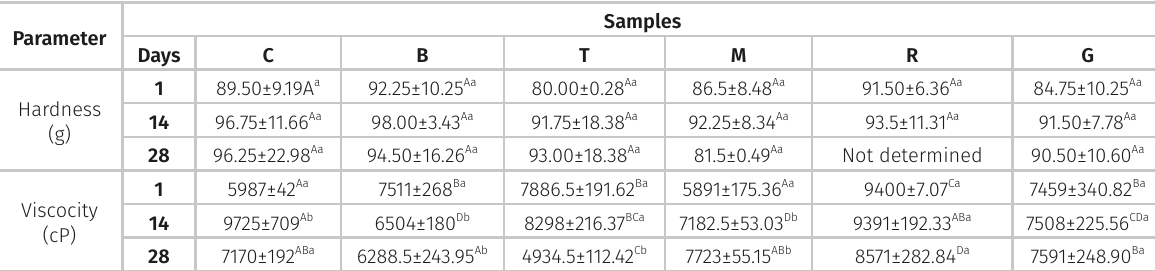
Table II. Hardness and viscocity values of yogurt samples during the storage period.